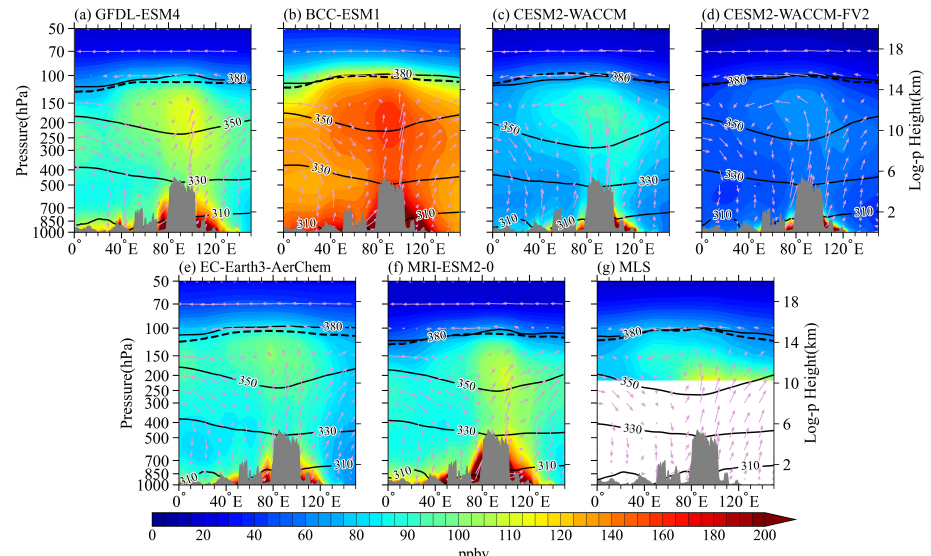
Figure 3. Same as Figure 2, but for longitude-height cross sections between 10 ◦ and 40 ◦ N.